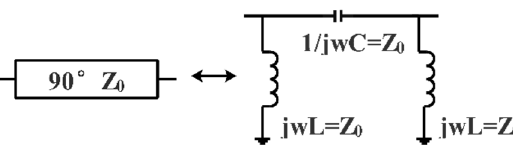
Figure 5. Ninety-degree TL converts to lumped π-type network.